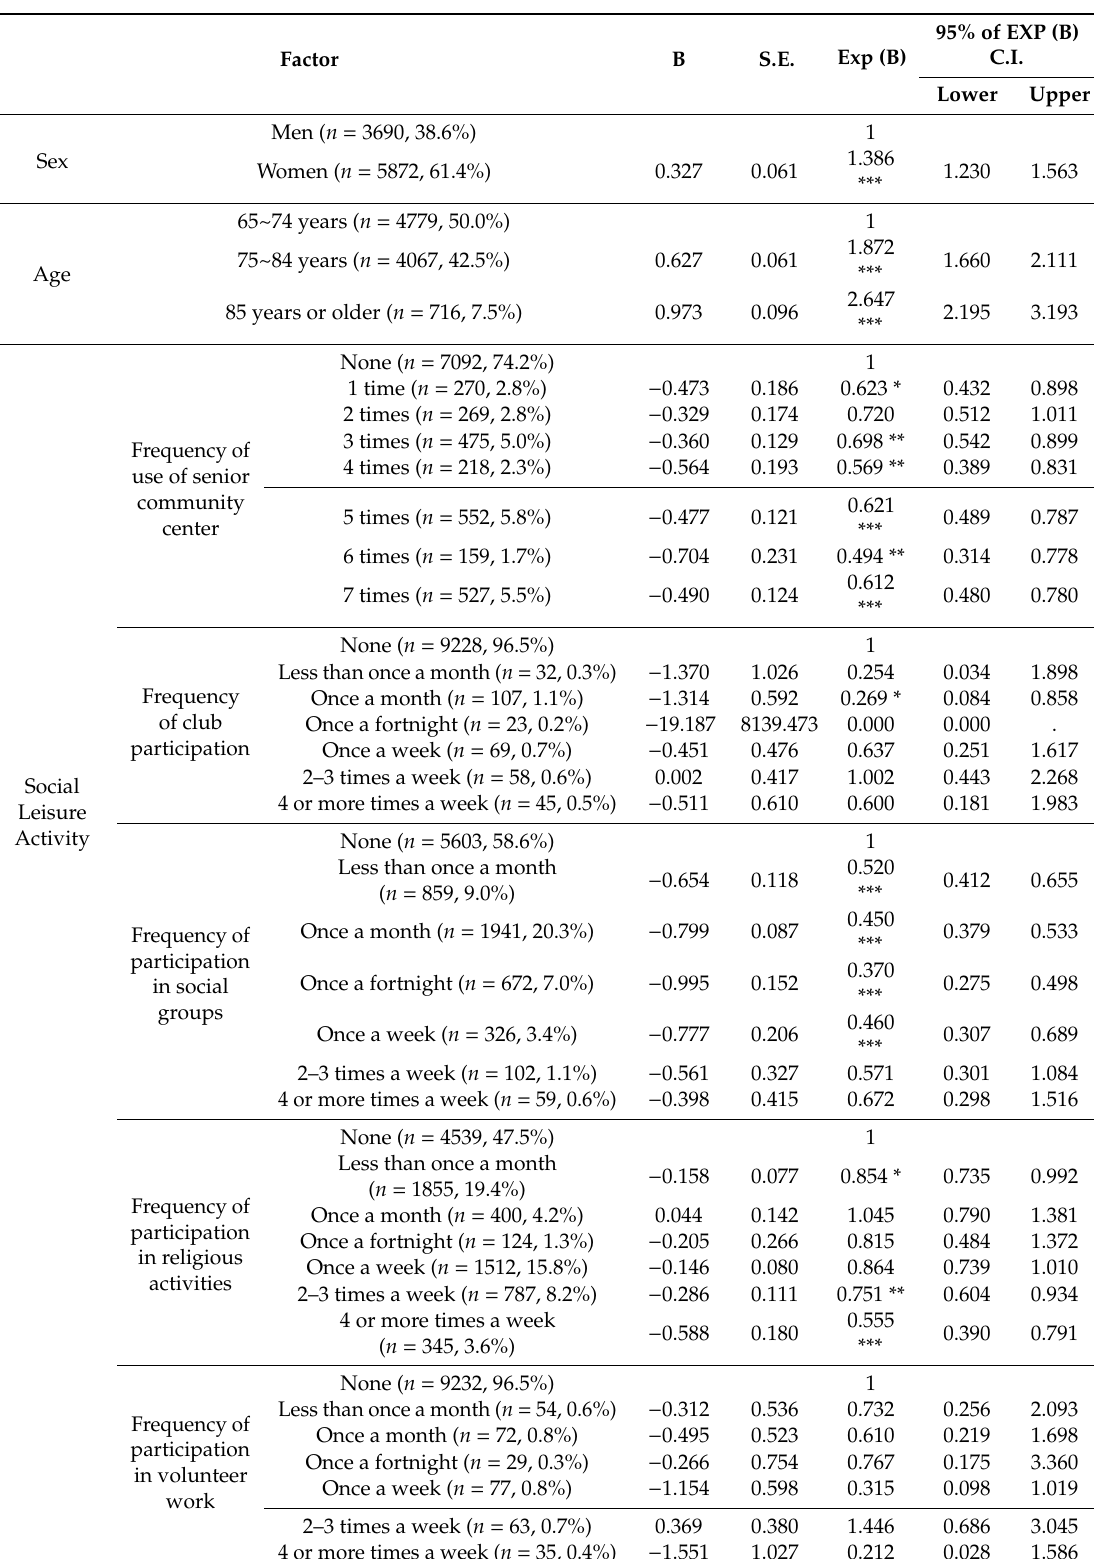
Table 6. Logistic regression analysis according to pre-frailty and frailty stages. Factor